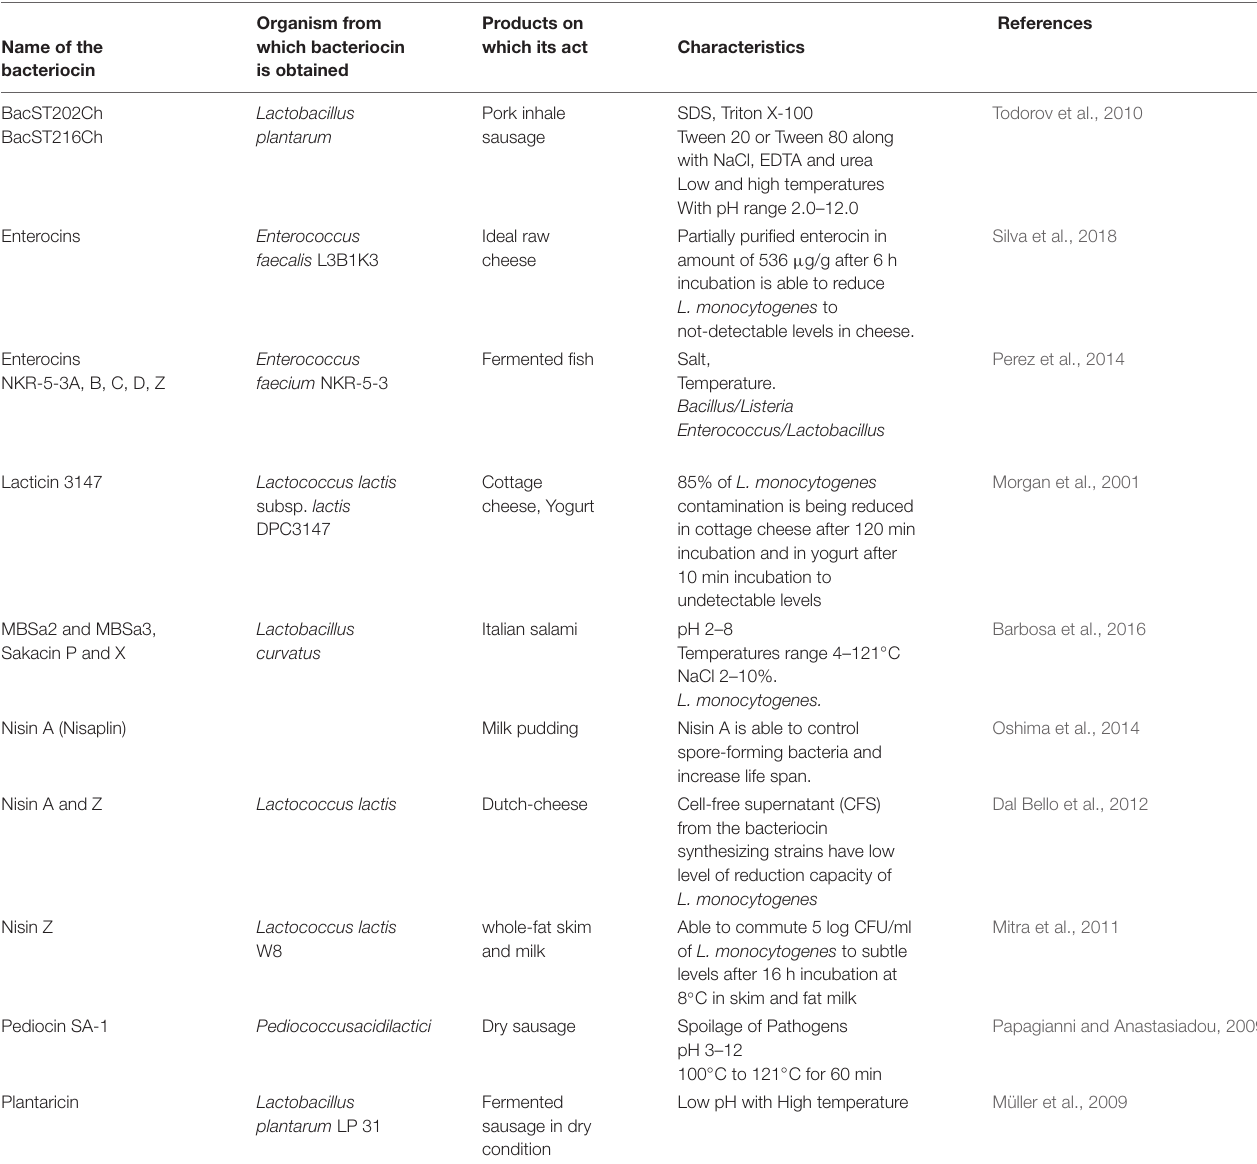
TABLE 1 | Bacteriocins used in the food